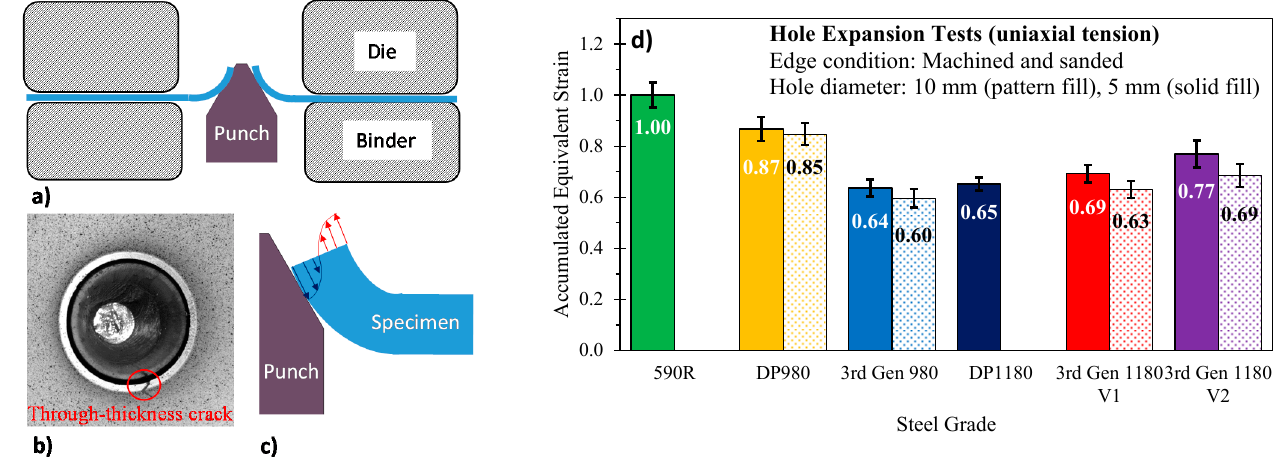
Figure 29. Schematic of hole expansion test ( a ), fracture initiation through the presence of a through-thickness crack for the 3rd Gen 1180 V1 (10 mm initial hole diameter) ( b ), schematic of the through-thickness strain gradient to suppress necking ( c ), and effect of the initial hole size (5 mm versus 10 mm diameter) for different steel grades ( d ). Note that the data for the DP1180 was retrieved from the Numisheet 2022 Benchmark [16] and the DP980 (10 mm hole size from Cheong [56], with both materials tested on the same equipment.